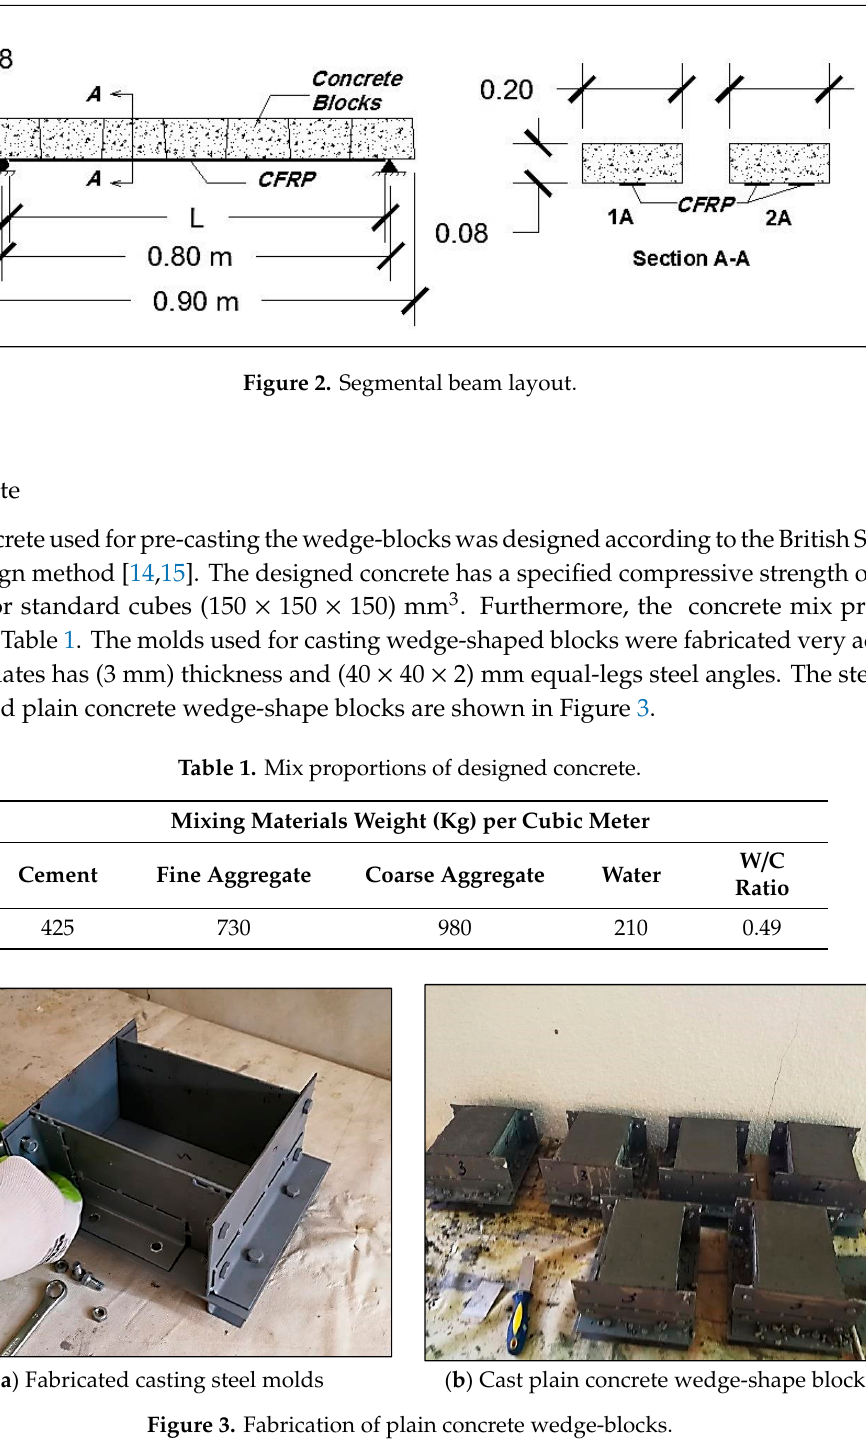
Figure 3. Fabrication of plain concrete wedge-blocks.